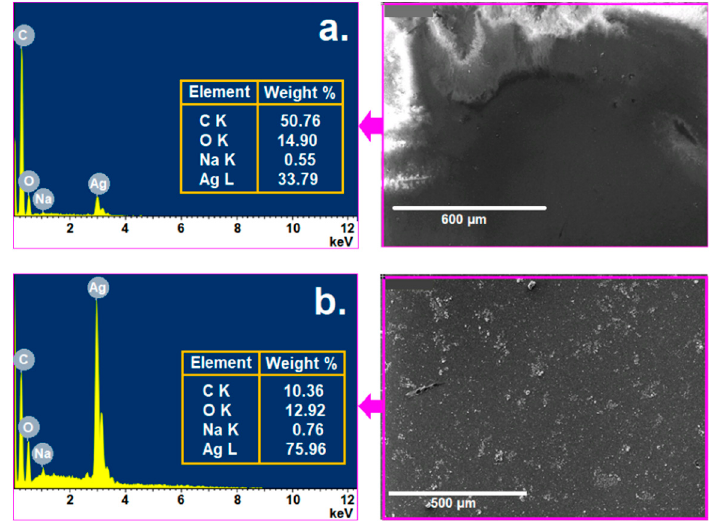
Figure 9. Energy-dispersive X-ray spectroscopy (EDS) microanalysis of the sample PEEK/Ag0.08 with a single ( a ) and with two layers ( b ).